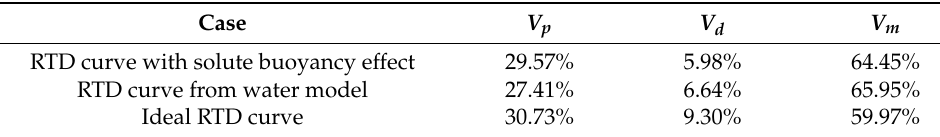
Table 6. RTD analysis results of numerical simulation and water model. Case